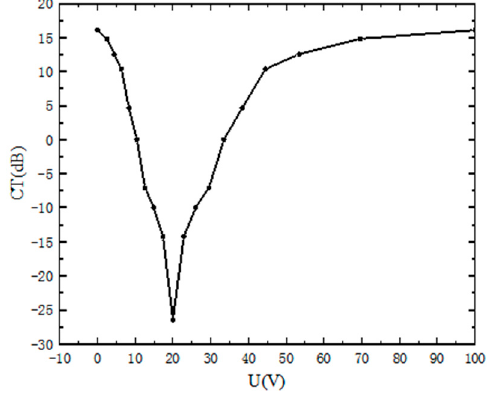
Figure 6. Variations of CT with the potential difference.